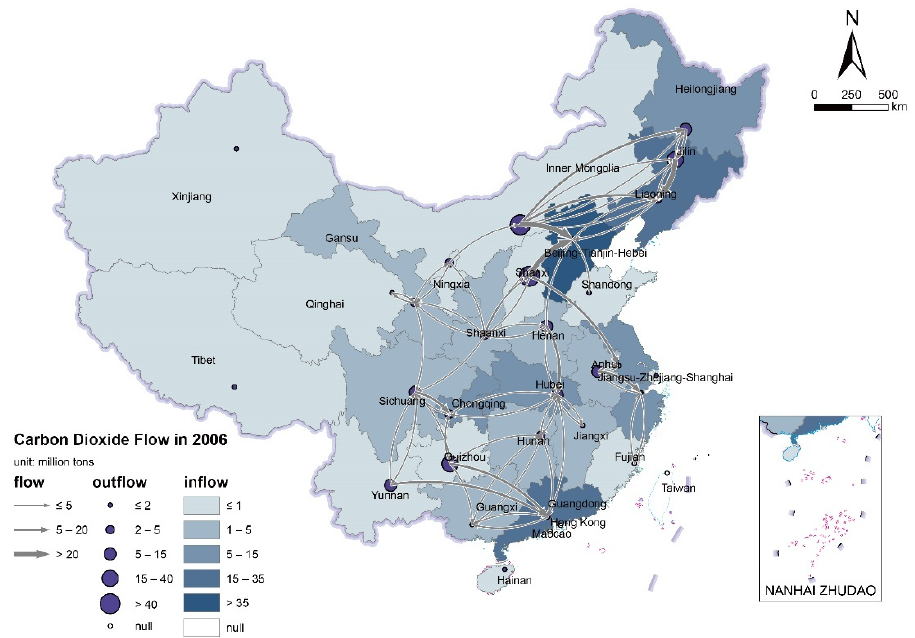
Figure 5. Spatial pattern of inter-provincial CO 2 flow from electricity, 2006.